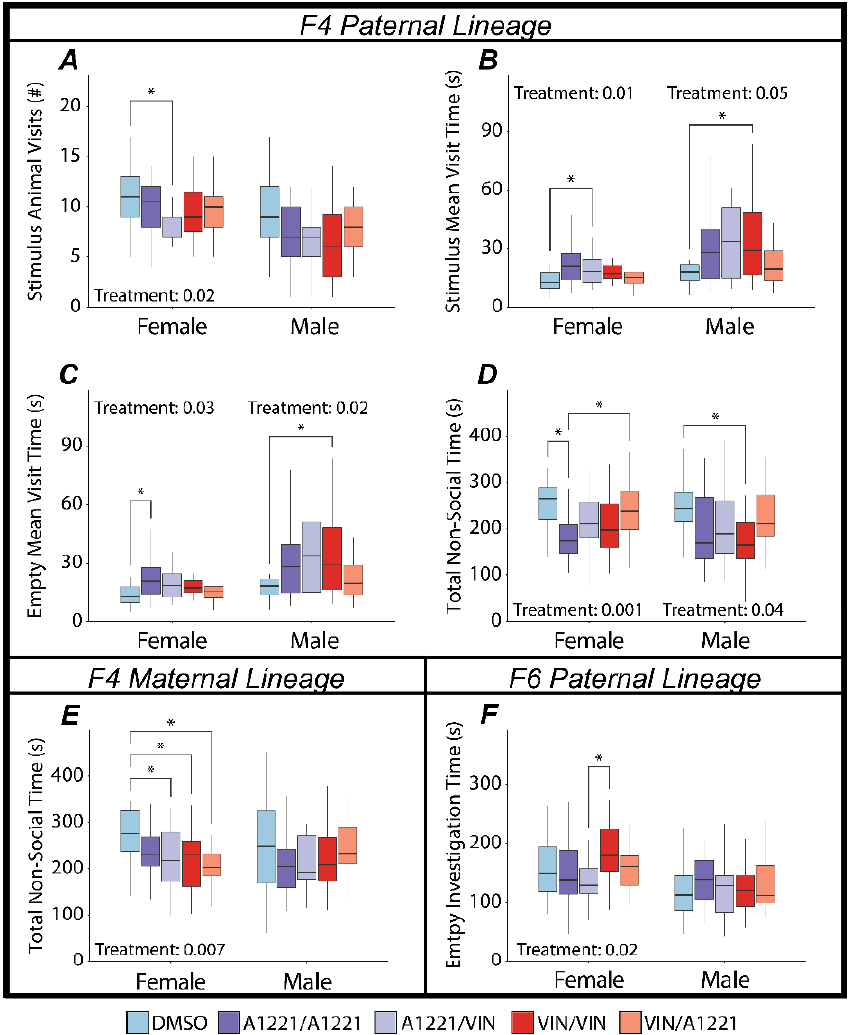
Figure 5. Aspects of social interaction dynamics in the test for sociability are graphed as box and whisker plots (minimum, 25% quartile, median, 75% quartile, and maximum). Main effects of treatment were determined by a one-way ANOVA within each sex and lineage, and indicated for p < 0.05. Significant post hoc results as determined by Tukey HSD and appropriately adjusted for multiple comparisons are indicated with bars connecting the respective groups (* <0.05). Shown are significant results for the F4 Paternal lineage ( A – D ), the F4 maternal lineage ( E ), and the F6 Paternal Lineage ( F ).